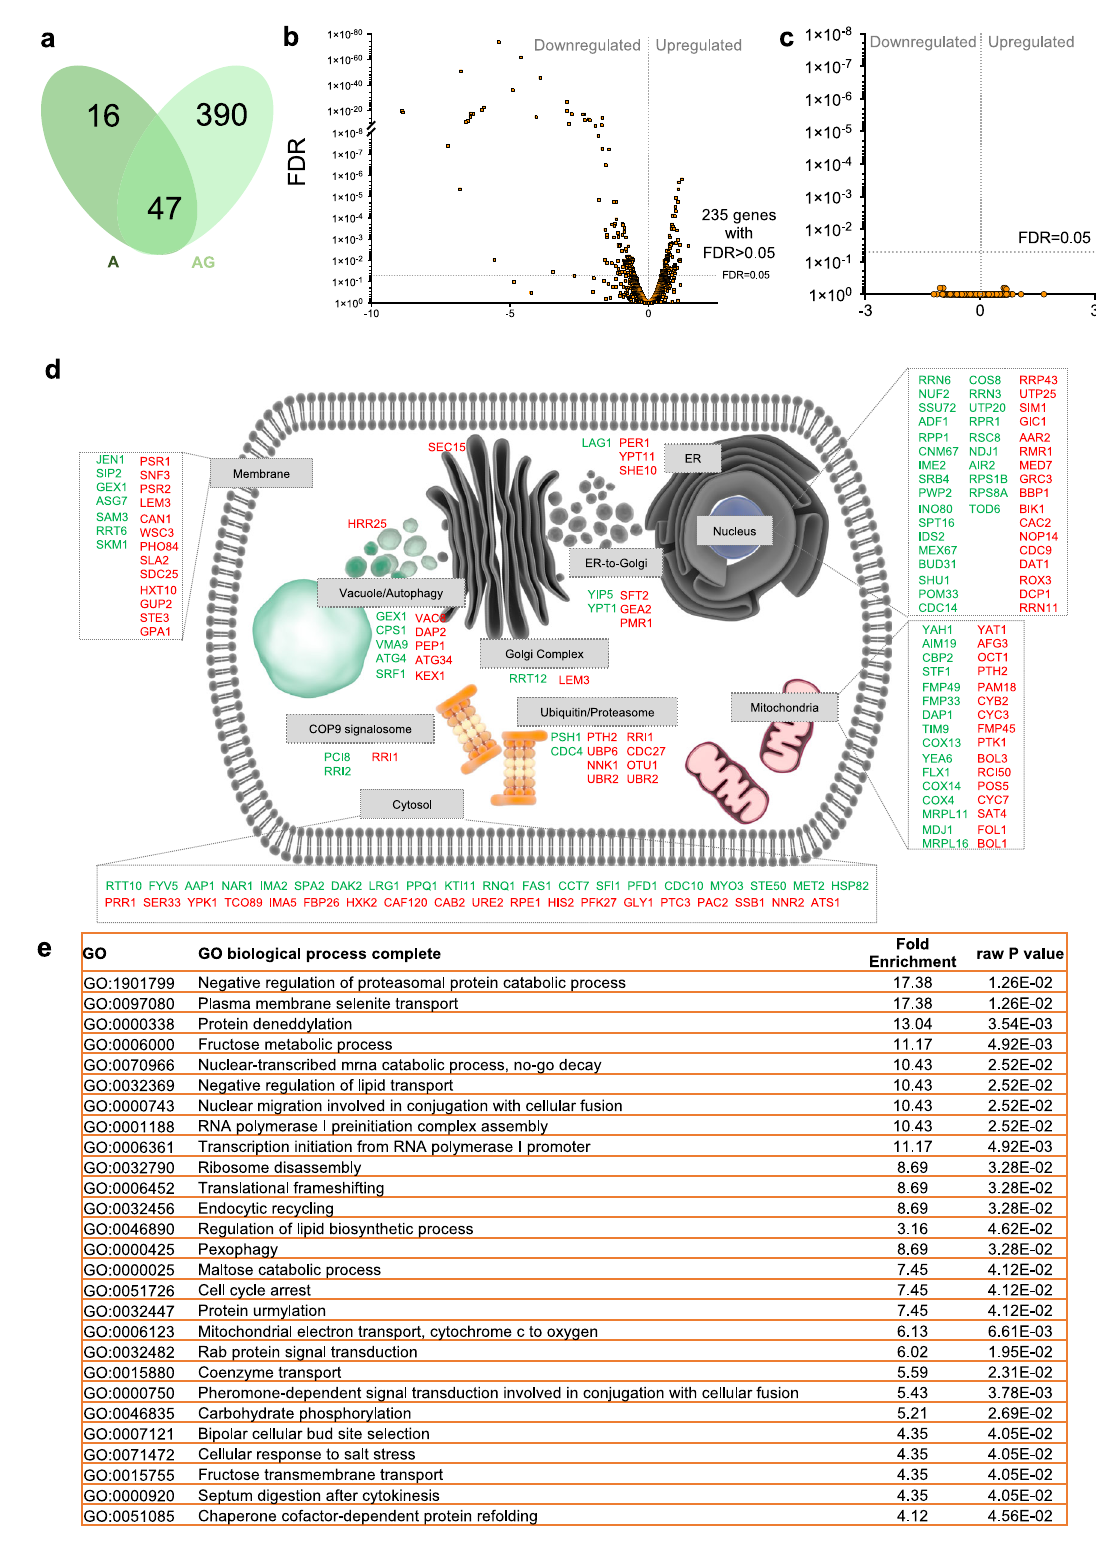
Fig. 4 | Genipin induces differential gene expression and it is dependent on α Syn-GFP expression. a Venn diagram of genes differentially expressed in α Syn- GFP expressing cells comparing with cells expressing the empty vector and α Syn- GFP expressing cells treated with genipin comparing with cells expressing the empty vector. b Volcano plot of differentially expressed genes in α Syn-GFP expressing cells treated with genipin comparing with α Syn-GFP expressing cells. c Volcano plot of differentially expressed genes in cells expressing the empty